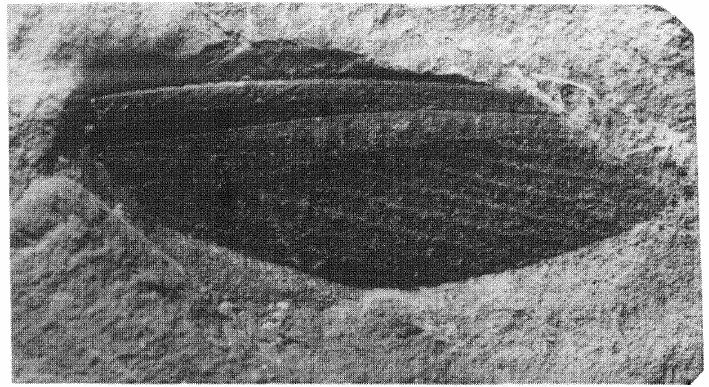
Fig. 23. Progenentomum carbonis, photograph of fore wing, based on holotype no. USNM 35580. Length 30 mm, as